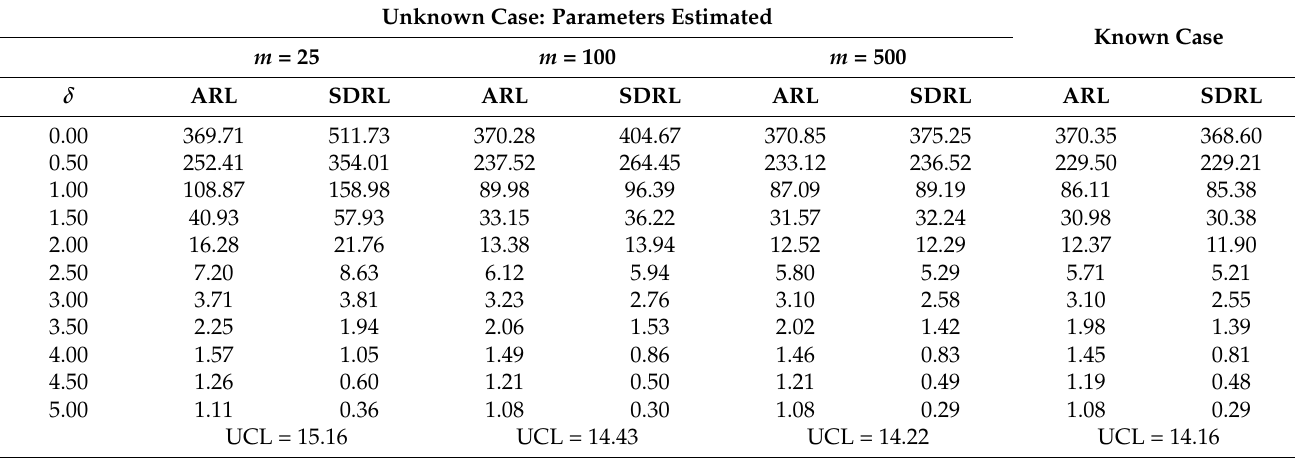
Table 2. ARL and SDRL values of the multivariate Shewhart control chart with p = 3.